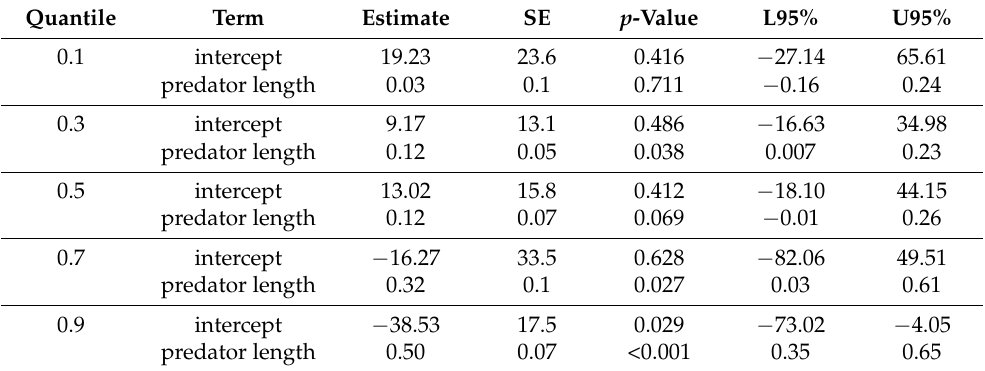
Table 2. Quantile regression model estimates from the examination of predator–prey length rela- tionships. Models reflect the relationship between Brown Trout ( Salmon trutta ) length (mm) and the lengths of their fish prey (mm). L95% = lower 95% confidence interval; U95% = upper 95% confidence